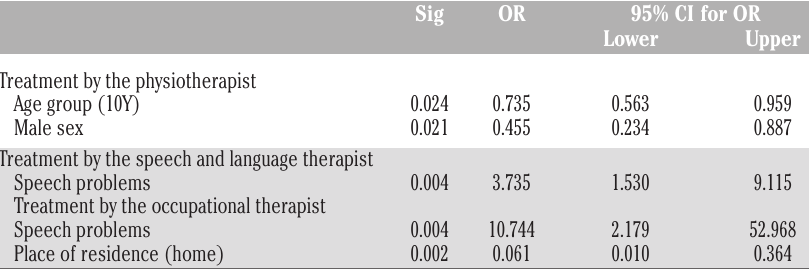
Table 4. Multivariate analyses after 6 months.